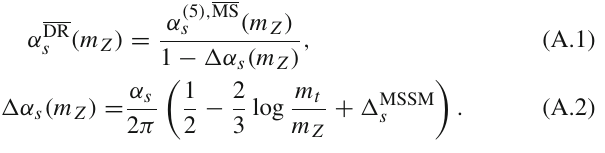
( M ) − λ max ( M ) of the two matching SUSY SUSY 2SM 1SM